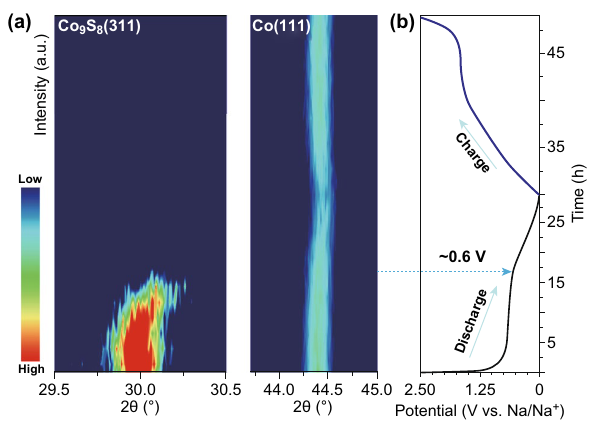
)1.25 0 Potential (V vs. Na/Na +